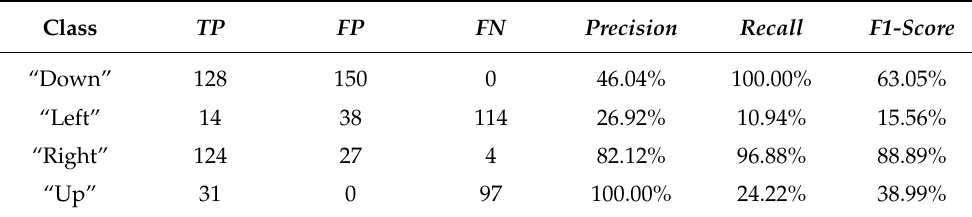
Table 5. Performance metrics of the network trained and validated with data in Figure 6b.